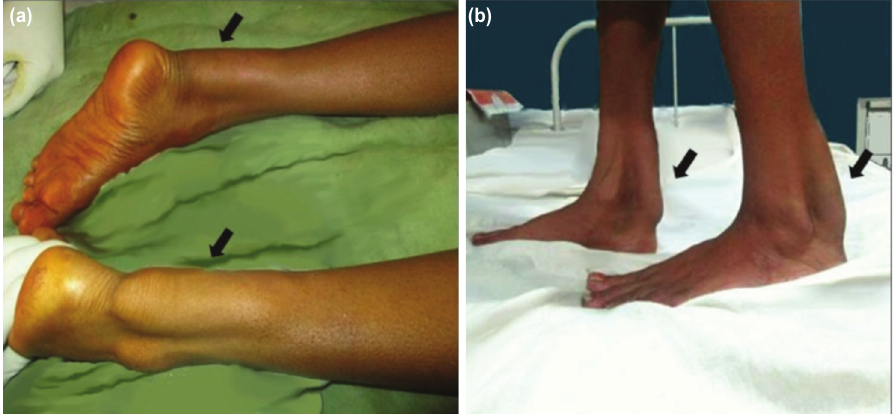
(a, b) Clinical photograph showing masses noted bilaterally on the posterior aspect of the legs above the calcaneus within the Fig. 1: achilles tendon (AT) (arrow).